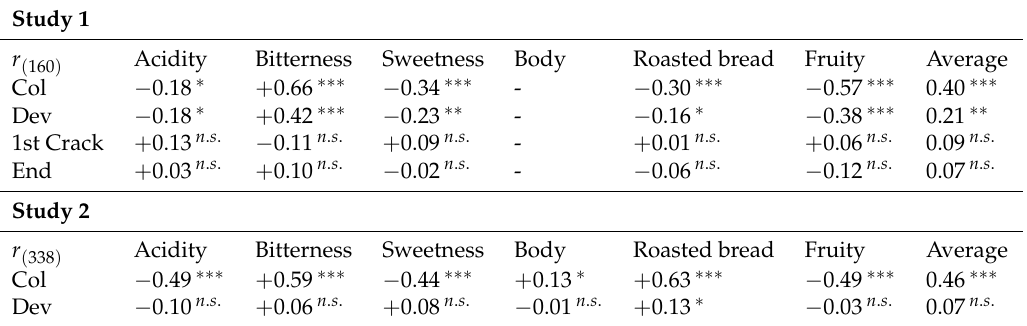
Correlation coefficients between roasting parameters (Col = roast colour, 1st Crack = time to first crack, End = total roasting time, Dev = development time) and sensory attributes for Studies 1 and 2. The two-tailed p -value associated with regression coefficient is also indicated ( n . s . p > 0.05; ∗ p < 0.05; ∗∗ p < 0.01; ∗∗∗ p < 0.001). To ease interpretation, the sign of the correlation